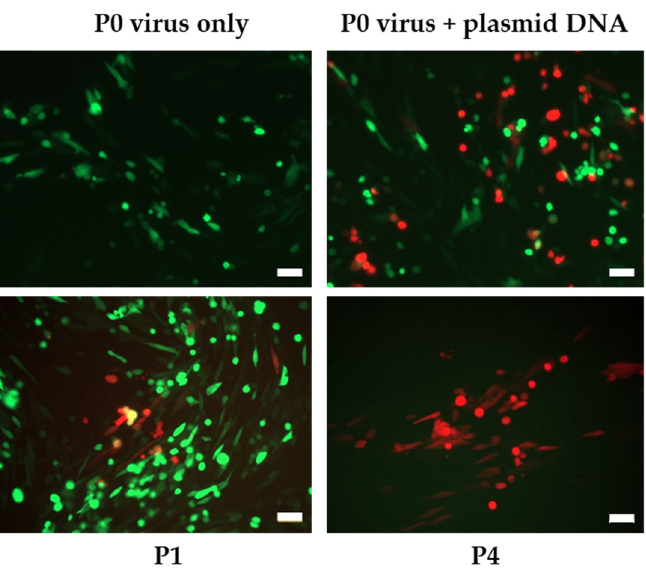
Figure 2. Generation of recombinant LSDVGC5 in BHK-21 cells from the parent LSDV(SODis)BEFV- Gb expressing eGFP. Plasmid DNA = transfer vector containing mCherry marker. P0 = initial infection and transfection of BHK-21 cells, P1 = passage 1, P4 = passage 4. Scale bar = 50µm.